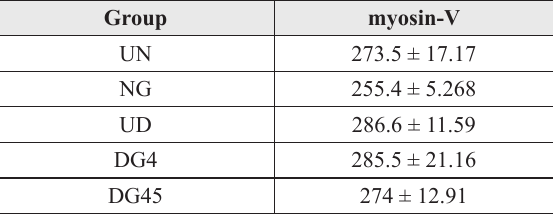
Means and standard errors of the cell body areas of myosin-V stained neurons in groups: untreated normoglycaemic (UN), glutamine-treated normoglycaemic (NG), untreated diabetic (UD), glutamine-treated diabetic (DG4), glutamine-treated diabetic (DG45). n = 5 rats per group.